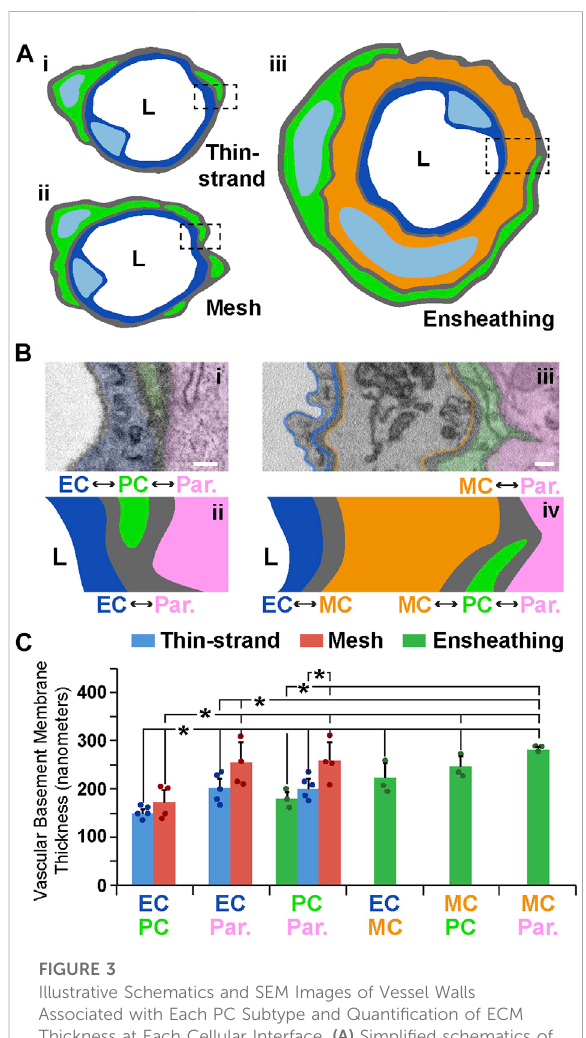
Illustrative Schematics and SEM Images of Vessel Walls Associated with Each PC Subtype and Quanti fi cation of ECM Thickness at Each Cellular Interface. (A) Simpli fi ed schematics of PCs (green) classi fi ed as thin-strand (i), mesh (ii), or ensheathing (iii), with associated endothelium (blue in i – iii) and a medial cell (orange in iii). “ L ” denotes the vessel lumen. Dashed rectangles indicate the type of vessel cross-section shown in (B) . (B) Annotated SEM images illustrating the relative location of the endothelium (blue, pseudo-color in i and drawn in ii, pseudo- outlineiniiianddrawniniv),PCs(green,pseudo-colorediniandiii, and drawn in ii and iv), brain parenchyma (pink – Par, pseudo- colored in i and iii, and drawn in ii and iv), and a medial cell (orange – MC, pseudo-outline in iii and drawn in iv). “ L ” denotes the lumen side. Each interface is denoted with double-sided arrows. Scalebars,200 nm. (C) Bargraphdisplayingthevascularbasement membrane thickness in nanometers for each of the types of cell- cell interface. Blue bars represent averages for TSPs, red bars represent averages for MPs, and green bars represent averages for EPs. A totalofn= 12 vessels wereanalyzed from n=10 mice. Error bars denote standard deviations. * p ≤ 0.05 for the comparisons